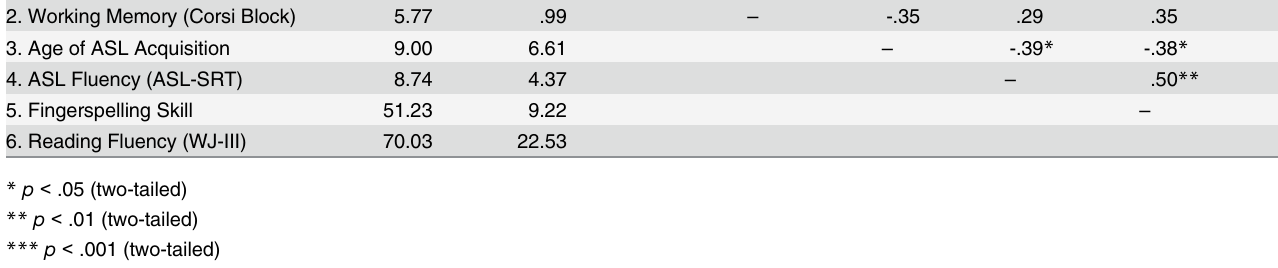
factors (VIFs) of 1.246, 1.555, and 1.446 indicated a small and acceptable degree of multicolli- nearity among them. The hypothesis was tested using a hierarchical multiple regression analysis. To investigate whether fingerspelling skill predicted reading fluency apart from age of ASL acquisition and general ASL linguistic proficiencies while controlling for cognitive functioning and working memory, the analysis was conducted by entering cognitive functioning, working memory, and age of ASL acquisition in the first step, ASL proficiency in the second step, followed by finger- spelling skill in the third step. The results are presented in Table 2. After controlling for cogni- tive functioning, the hierarchical multiple regression analysis found fingerspelling skill to significantly predict reading fluency ( Δ R 2 = .19, Δ F (5, 25) = 11.65, p = .002, β = .53) over and above age of ASL acquisition and ASL proficiency. Together, the three predictors described 59% of the variance in reading fluency scores. Table 2. Summary of hierarchical multiple regression analysis for age of ASL acquisition, ASL fluency, and fingerspelling skill predicting reading fluency scores. Predictor and Step